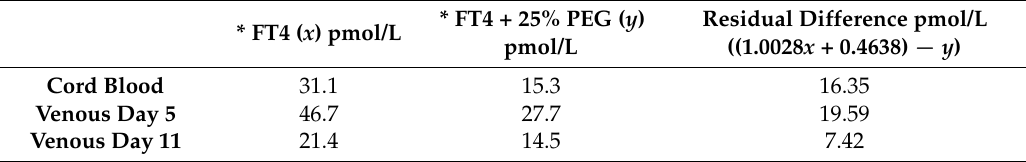
Table 1. Data showing residual difference between FT4 values pre and post 25% PEG treatment.